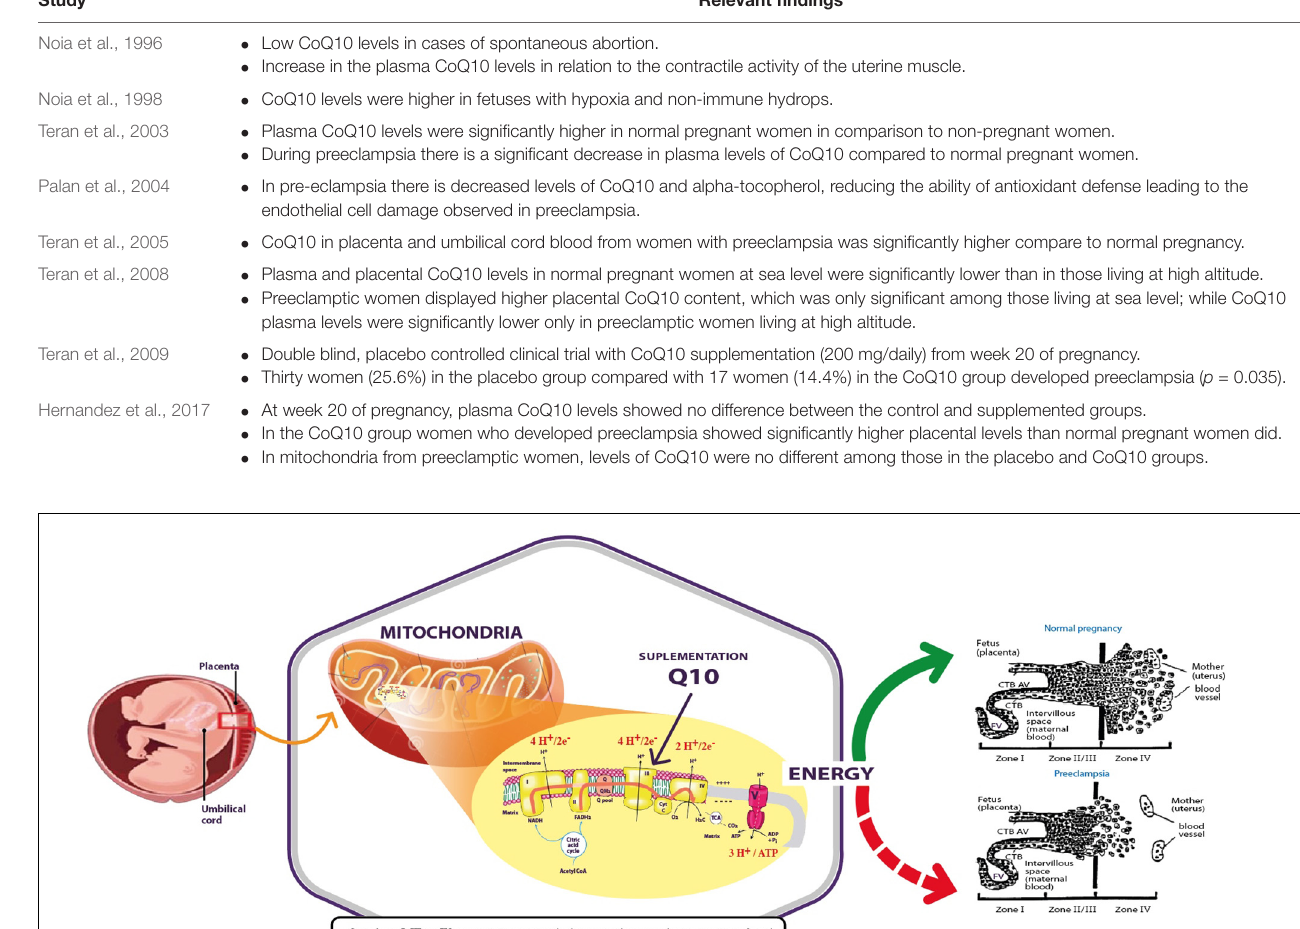
TABLE 2 | Studies involving Coenzyme Q10 (CoQ10) during normal pregnancy and preeclampsia. Study Relevant findings